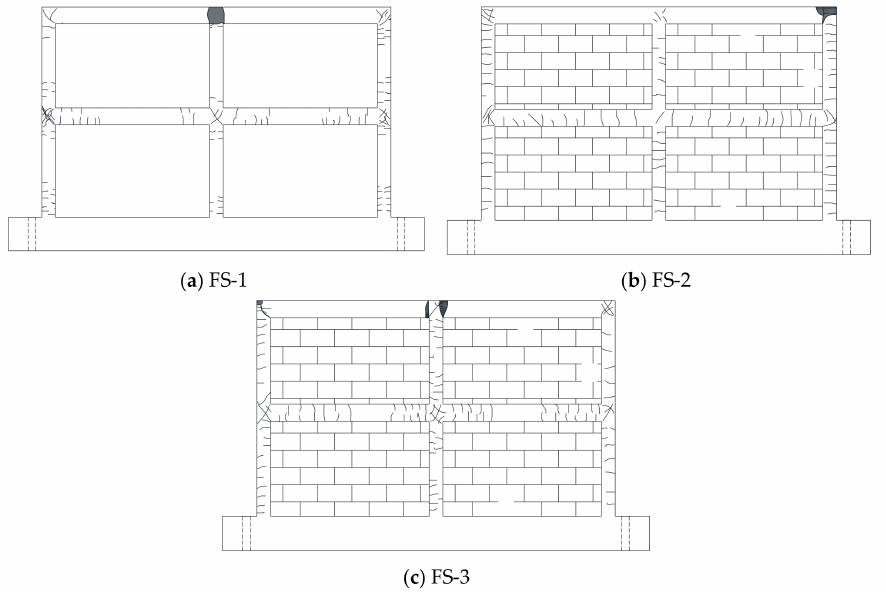
Figure 6. Details of the measurement.